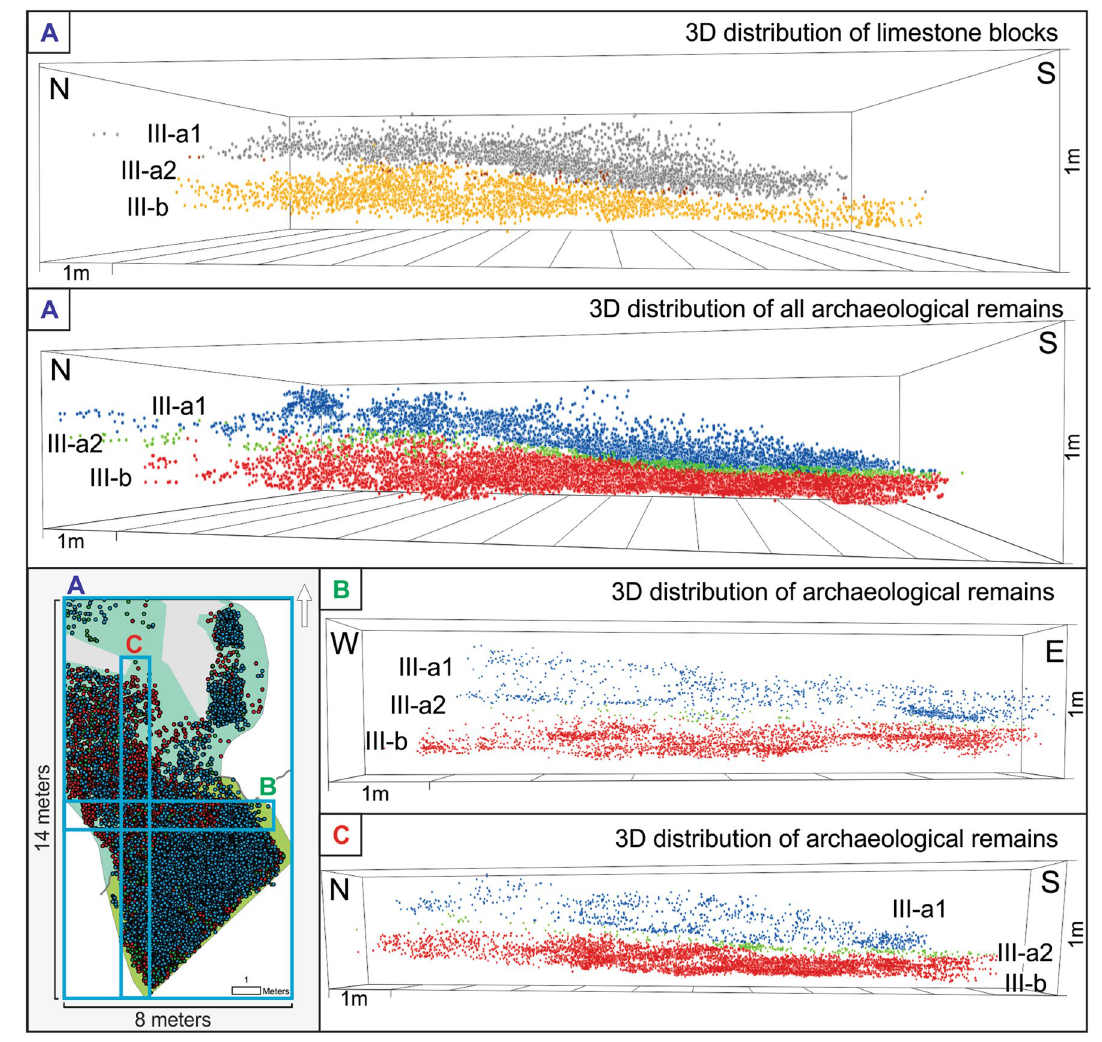
Figure 4. Vertical distribution of limestone blocks and archaeological items in subunits III-a1, III-a2 and III-b of Teixoneres Cave. The figure was prepared with the ArcGIS Version 10.5